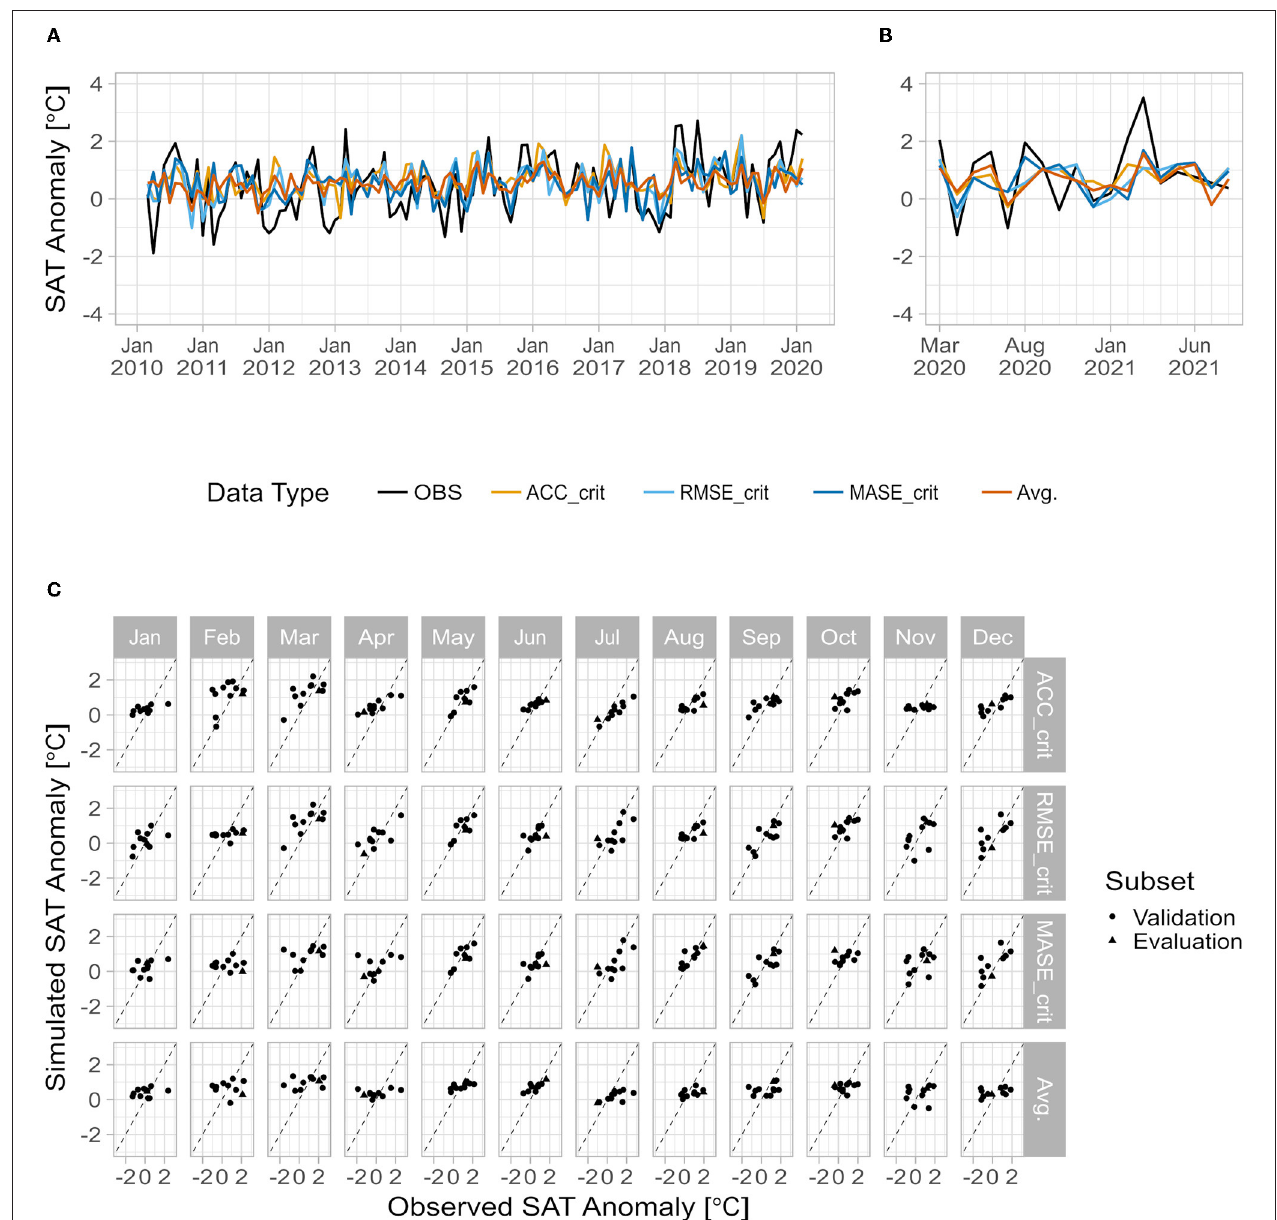
FIGURE 8 | (A) Observed (black line) and predicted SAT index anomalies in the Kant¯o region for the validation period. Time series of the prediction consist of the average of the models (orange line) and optimized time series according to the anomaly correlation coefficient (yellow line), the root mean square error (cyan line) and the mean absolute scaled error (blue line). Long-term and monthly linear trends are restored. (B) Same as (A) but for the evaluation period. (C) Monthly stratification of scatter plots of the observed anomalies (x-axis) vs. the predicted anomalies (y-axis). Black dots are the forecasts for the validation period and black triangles for the evaluation period. Rows correspond to the different types of prediction system and columns to the